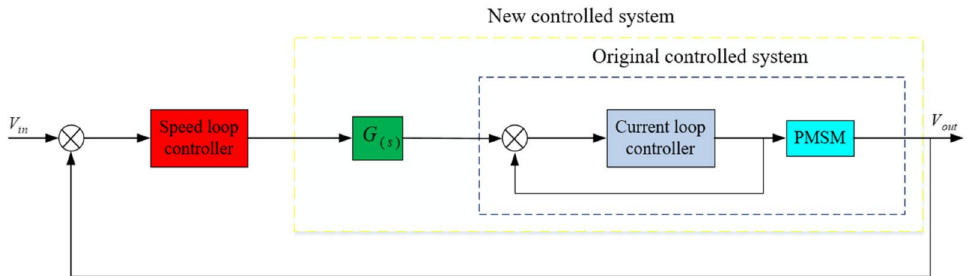
Figure 10. Schematic diagram of model calibration.